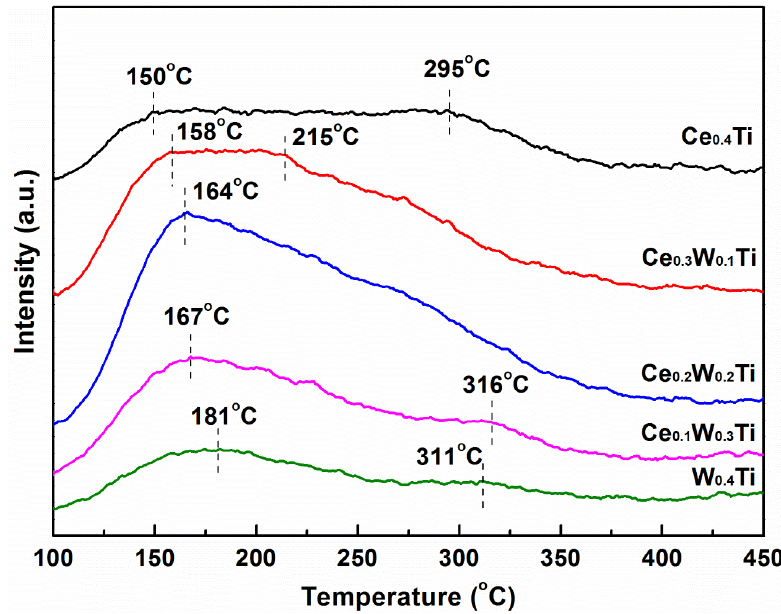
Figure 5. NH 3 -TPD profiles of the Ce-W-Ti catalysts.